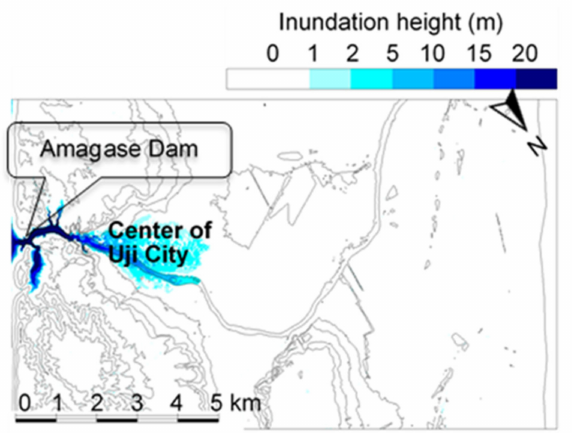
Figure 20. (Case–1). Inundation height, 10 min after start of the calculation.